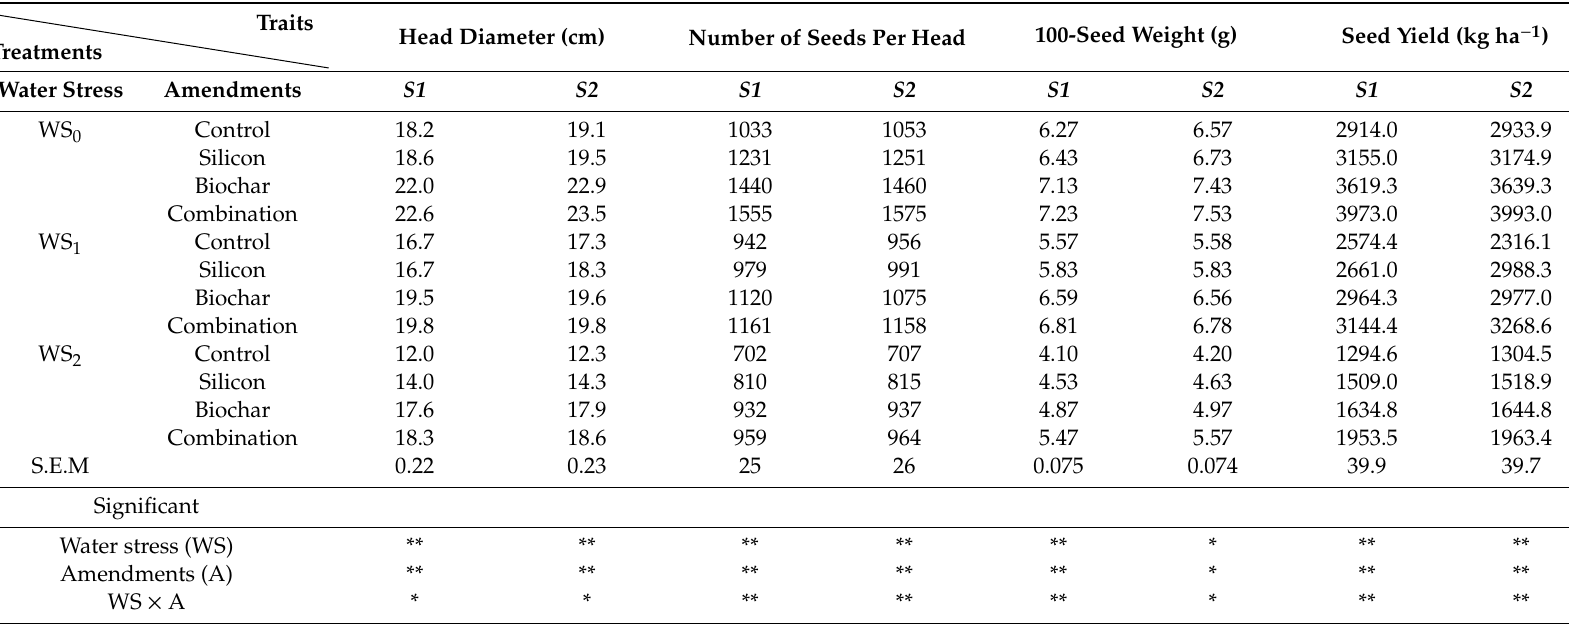
Table 4. Interaction e ff ects of amendments and water deficit stress treatments on yield and related traits of sunflower during two growing seasons 2016 and 2017.